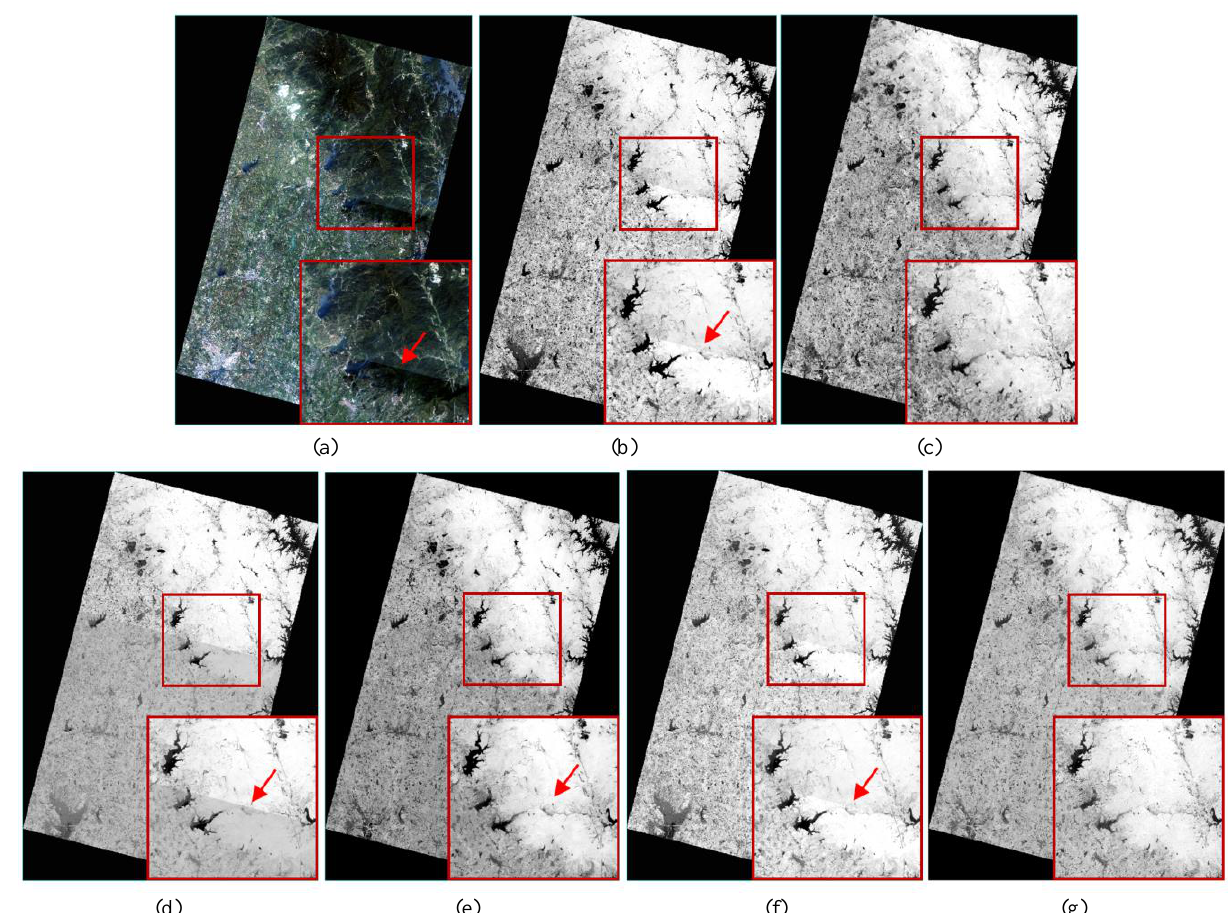
Figure 3 . (a) Reflectance data before normalization, (b) NDVI data before normalization, (c) standard NDVI data, (d) NDVI data after SGloLM normalization, (e) NDVI data after SGloLM+MVC normalization, (f) NDVI data after MGloLM normalization, (g) NDVI data after MGloLM+MVC normalization NDVI